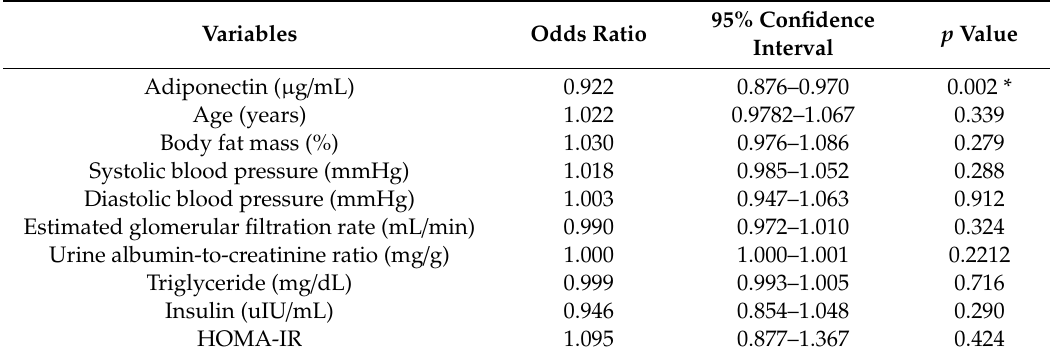
Table 2. Multivariable logistic regression analysis of the factors associated with aortic sti ff ness among the 140 type 2 diabetic mellitus